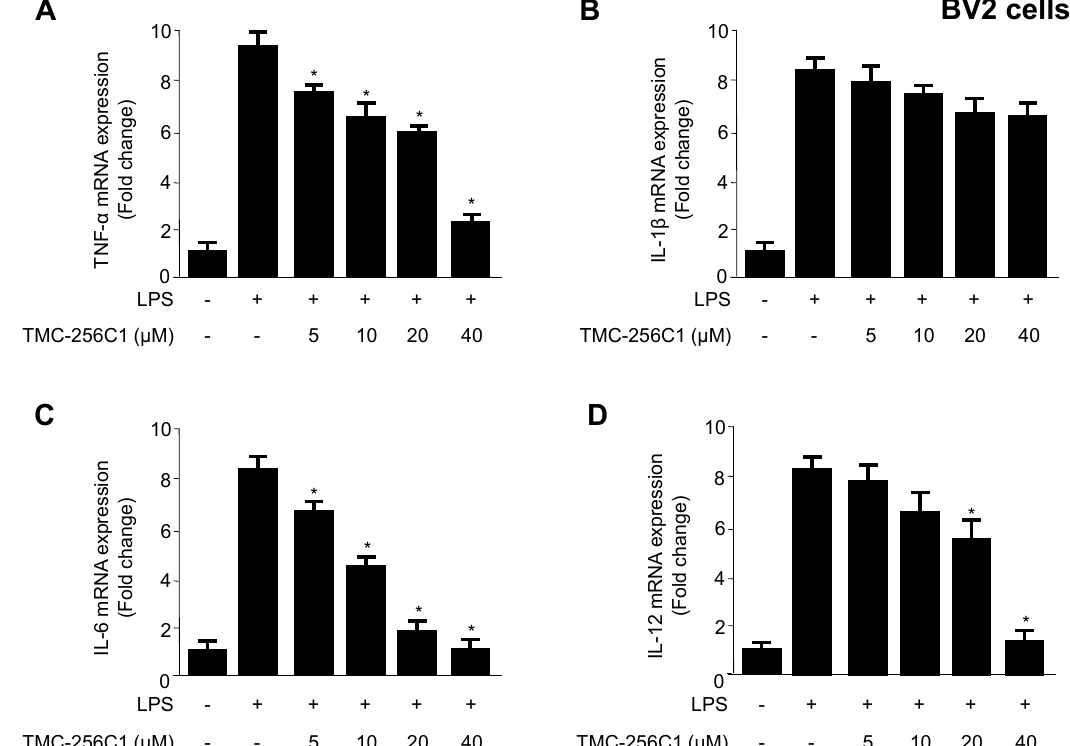
Figure 3. Effects of TMC-256C1 on mRNA expression levels of TNF- α ( A ); IL-1 β ( B ); IL-6 ( C ); and IL-12 ( D ) in BV2 cells stimulated with lipopolysaccharide (LPS). Cells were pre-treated for 3 h with the indicated concentrations of TMC-256C1, and then stimulated for 12 h with LPS (1 μ g/mL). The concentrations of TNF- α ( A ); IL-1 β ( B ); IL-6 ( C ); and IL-12 ( D ) were determined as described in the Experimental Section. Data represent the mean values of three experiments ± SD. * p < 0.05 compared to the group treated with LPS.